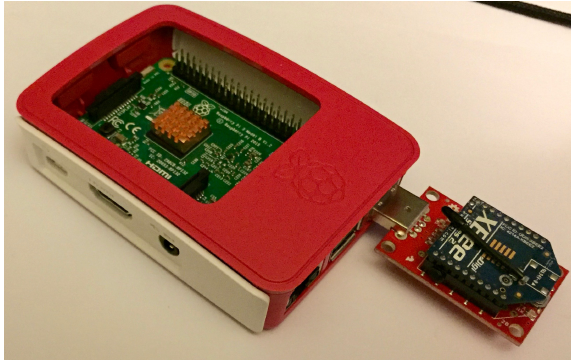
Figure 11. Photograph of Raspberry Pi 3-based sink node